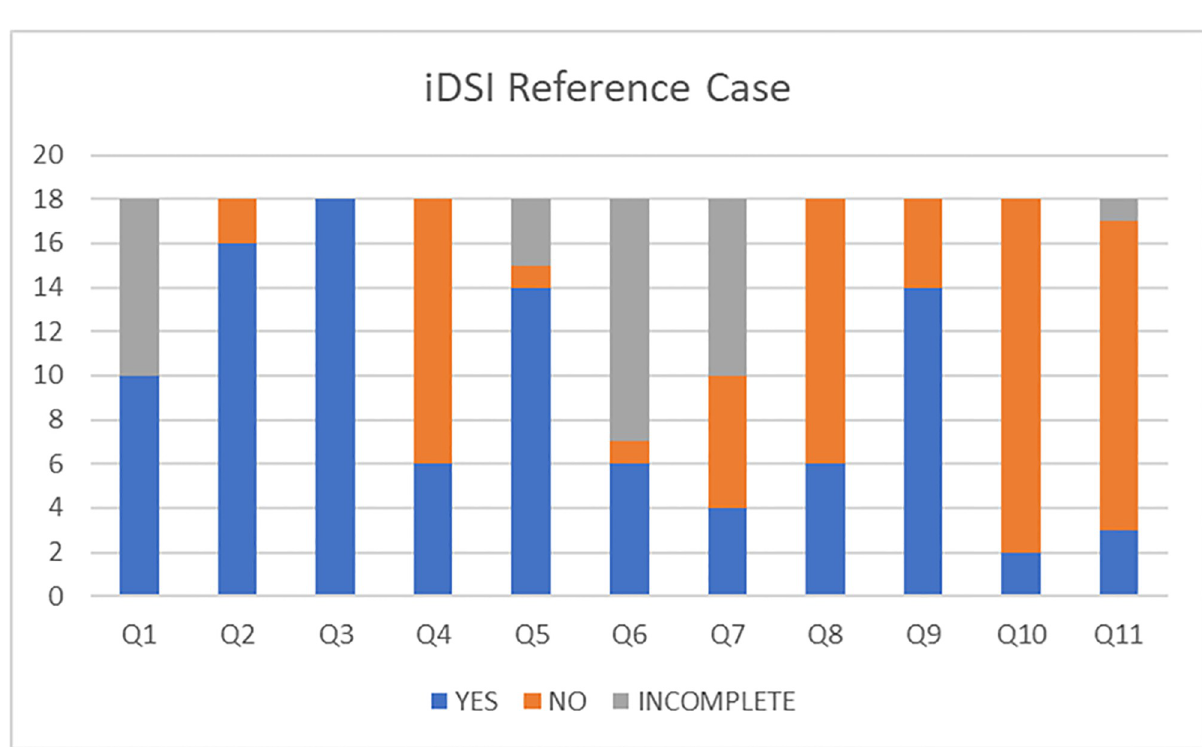
Fig 4. iDSI Reference Case (Wilkinson et al.,2016) [See S4 and S5 Tables for more detail].